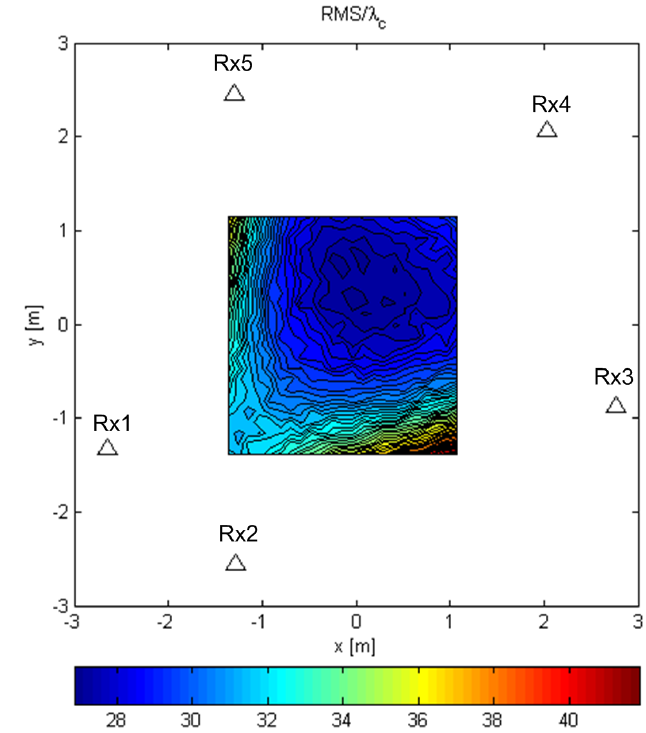
Figure 10. MCME RMSE/ λ c for random Gaussian